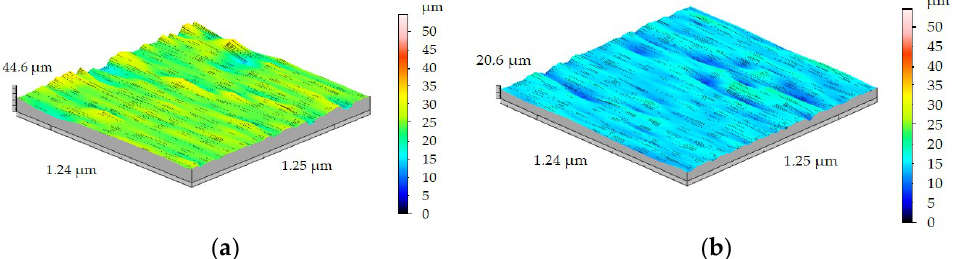
Figure 14. Results of 3D surface measurement samples after turning with f = 0.1 mm/rev of: ( a ) FEPA 046, ( b ) FEPA 100.